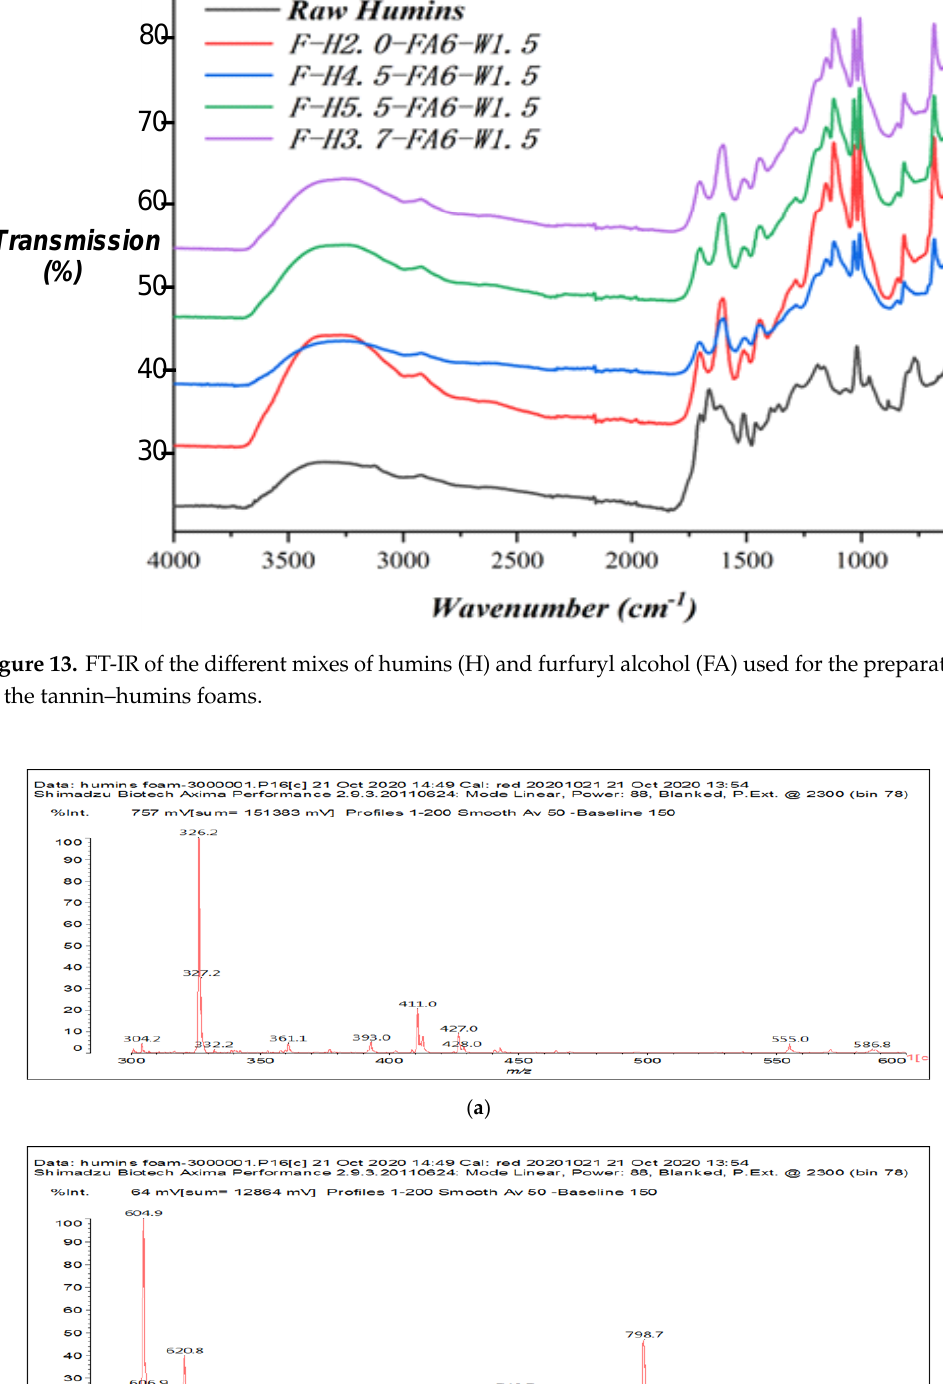
Scheme 5. Examples of structures produced in the foams coreaction showing that flavonoid monomers and oligomers do react with simple humins structures.